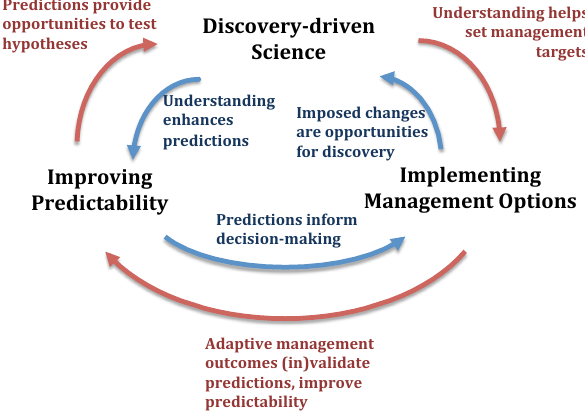
Fig. 7. A conceptual structure for “use-based” hydrology, en- compassing management, pragmatic prediction and fundamental